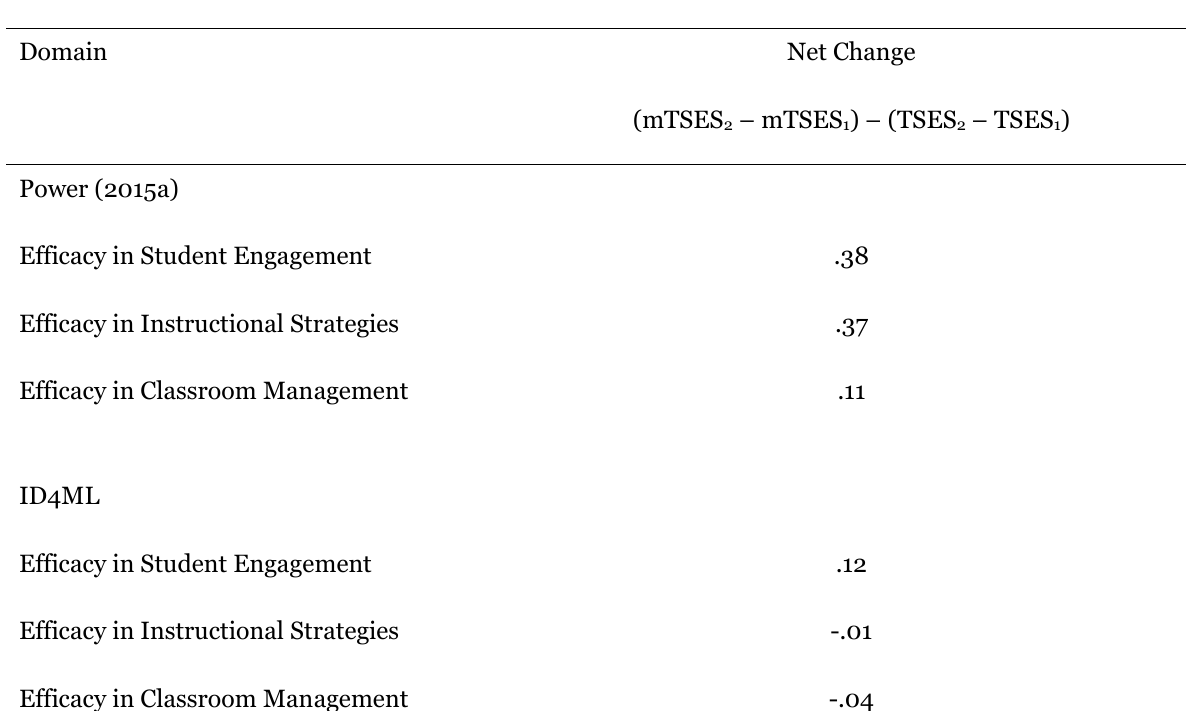
Table 5 Net Change (Intervention